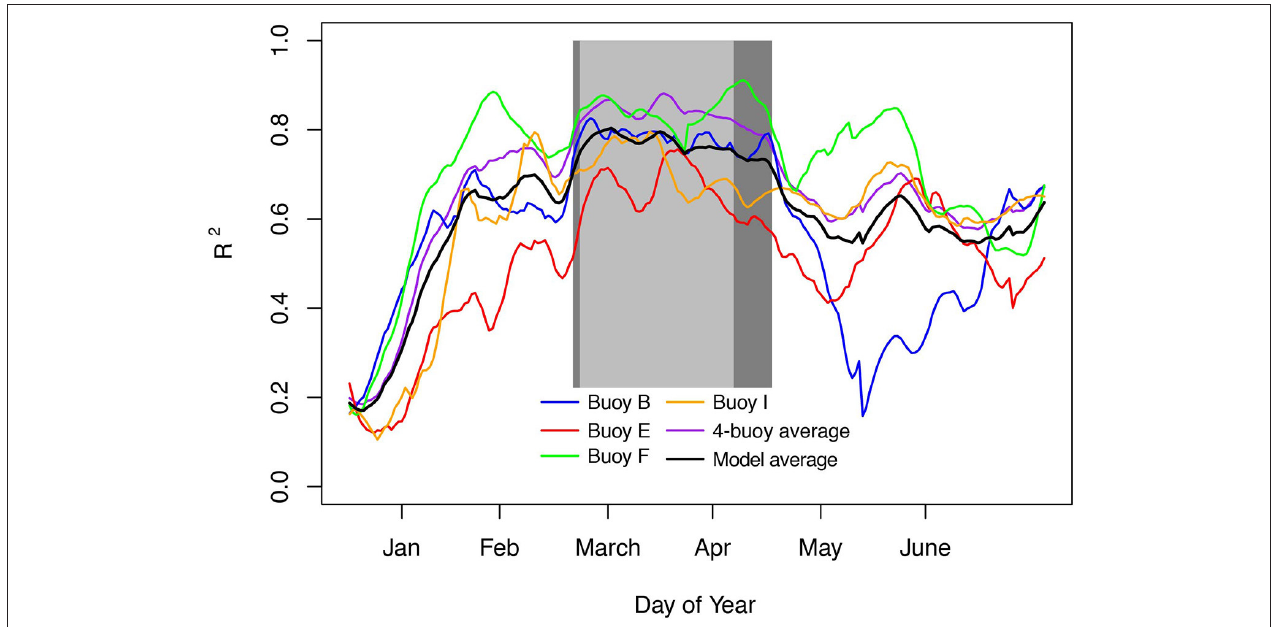
FIGURE 5 | Temperature and start day correlations. Temperatures on January 1 through June 30 at each buoy and for the 4-buoy average were used to predict the start day of the fishery. Results show the R 2 -value of these regression models by day. The model average R 2 -values exceeded 0.75 from March 8 through April 20 (light gray rectangle) and were above 0.7 for March 6 through May 3 (dark gray rectangle).